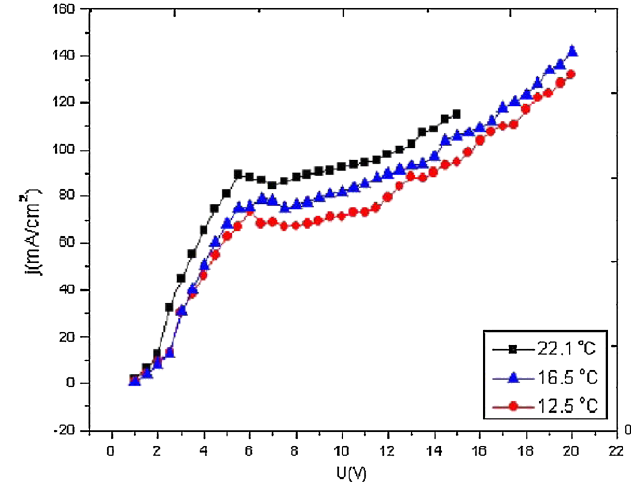
FIG. 3. (Color) Development of the I-V curve with different rotational speed of the stirring bar at 25 (cid:3) C